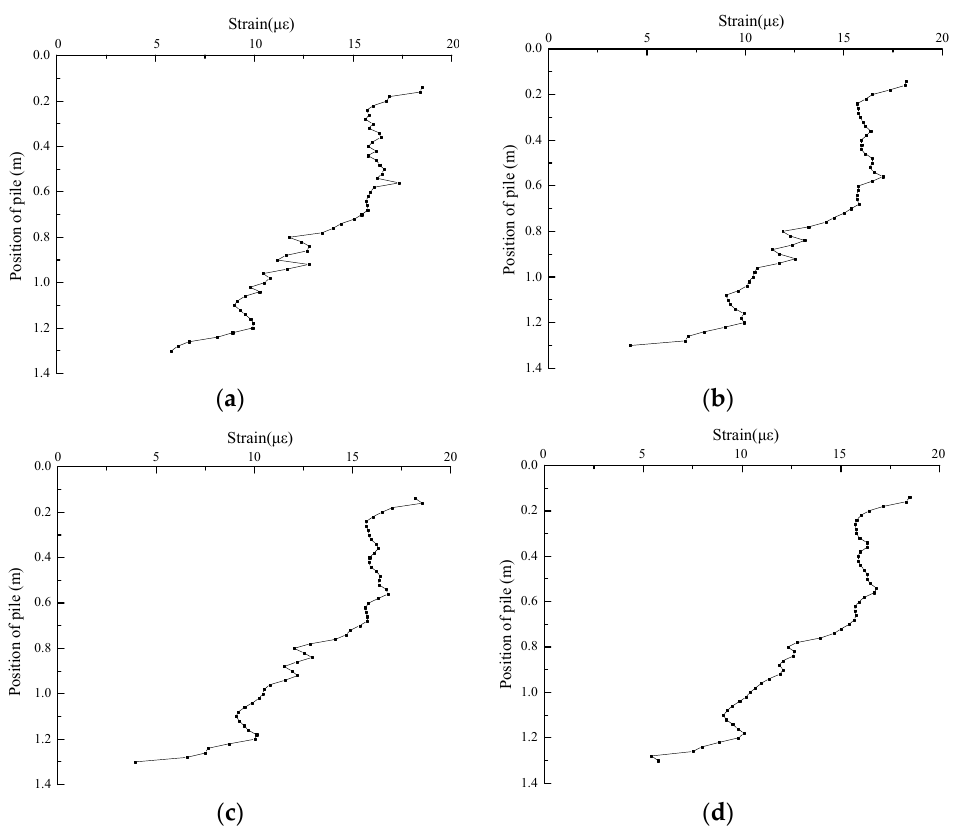
Figure 9. Process using wavelet transform to deal with the strain data. ( a ) Initial data; ( b ) Level 1; ( c )